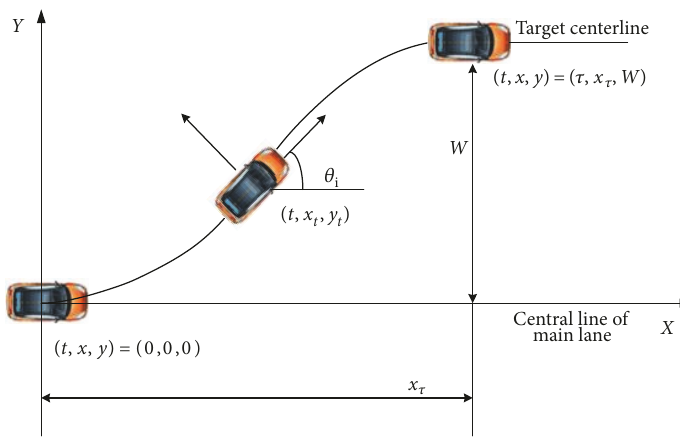
Figure 2: Vehicle track during the course of